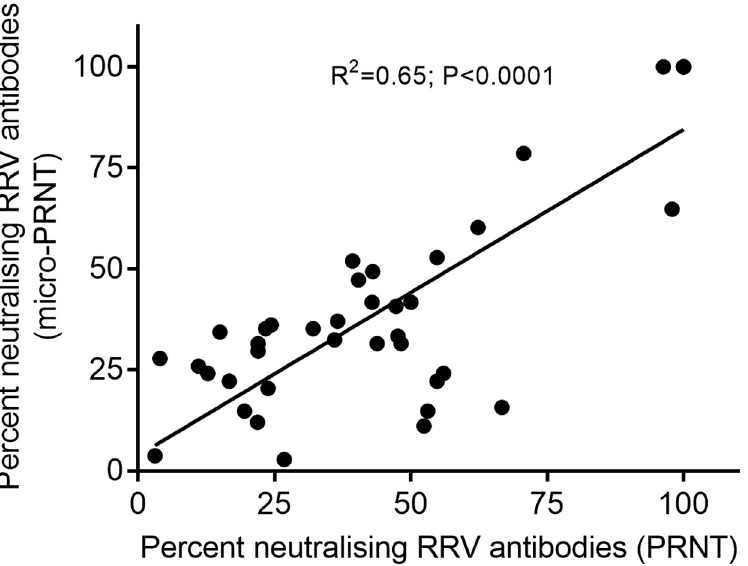
Fig 2. Plaque neutralisation demonstrated by standard PRNT or micro-PRNT using koala serum samples. Correlation of percent reduction in plaque forming units as measured by standard PRNT (x-axis) and micro-PRNT (y- axis)